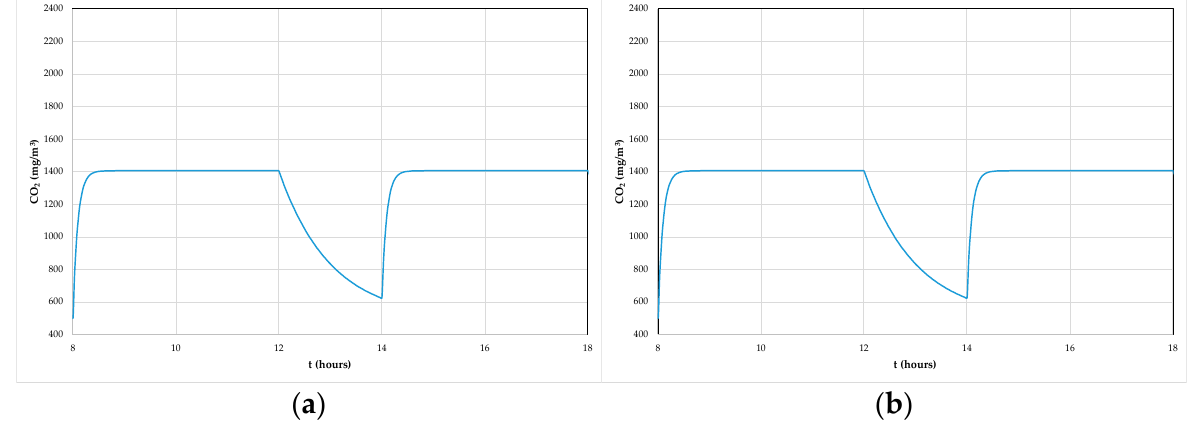
Figure 7. Evaluation of carbon dioxide (CO 2 ) concentration for Case A ( a ) and Case B ( b ).